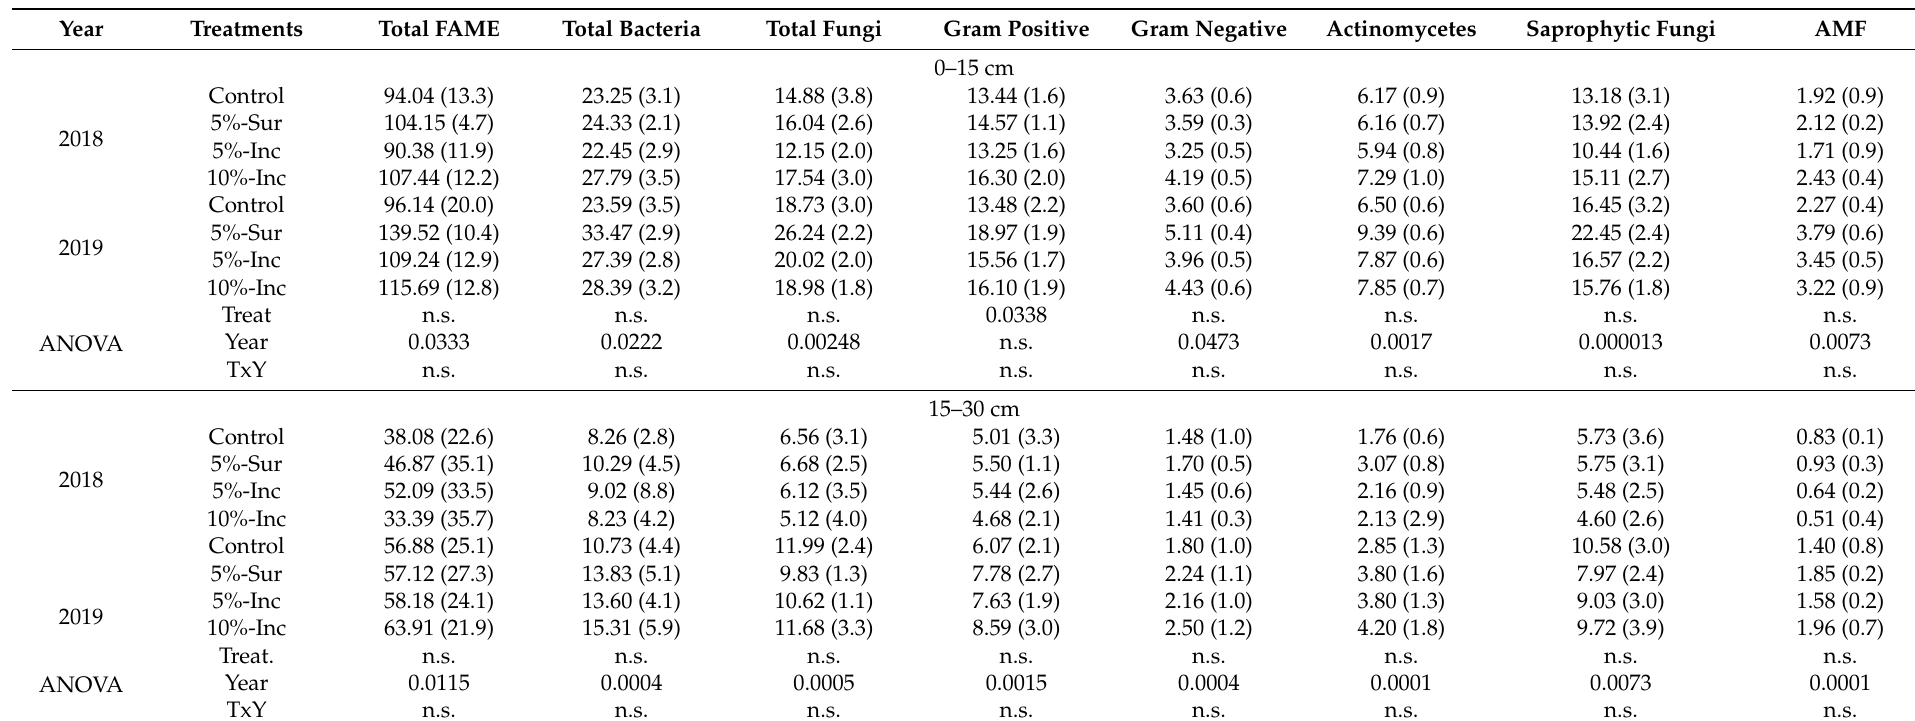
Table 1. Abundance of microbial fatty acid methyl ester (FAME) indicators groups with and without biochar addition. Numbers in bracket represent standard error of the means ( n = 6). Inc: incorporated; Sur: surface; non-significant ( p -value > 0.05). The letter indicates statistical significance differences based on the Fisher’ LSD test with a p -value <